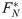
Illustration of the mortality rates m
i as a function of reserves x when foraging at the appropriate rate to maintain reserves at x (dashed line) and when resting (solid line) for a specific model implementation (see Appendix).The mortality from starvation (m
S, green line) declines rapidly with increasing fat reserves x, and so is only substantial at low reserves. The mortality from obesity (m
B, blue line) is small at low reserves and increases at an accelerating rate. Mortality due to predation during foraging (m
P, red line) increases with reserves. The optimal normal fat level FN* is at the minimum of the sum of the mortality rates under normal conditions (m
S + m
B + αm
P). During a glut, the animal should feed up to reserves level FG* where the mortality from obesity causes total mortality (not including m
P, which is zero while resting) to equal that at FN* (dotted lines). It can then rest, avoiding the risk of predation, until its reserves fall to FN*, whereupon it must start to forage again before it suffers a large increase in mortality due to low reserves. Parameter values: γ = 10, ψ = 3, μ = 0.005, ϕ = 2, β = 3, κ = 0.01, ρ = 0.0001.